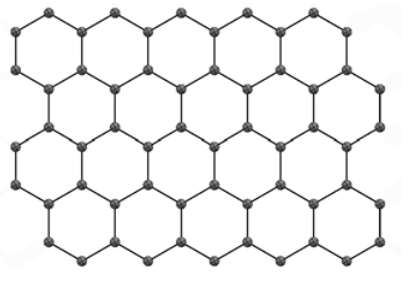
Figure 1. Crystal structure of ice I not